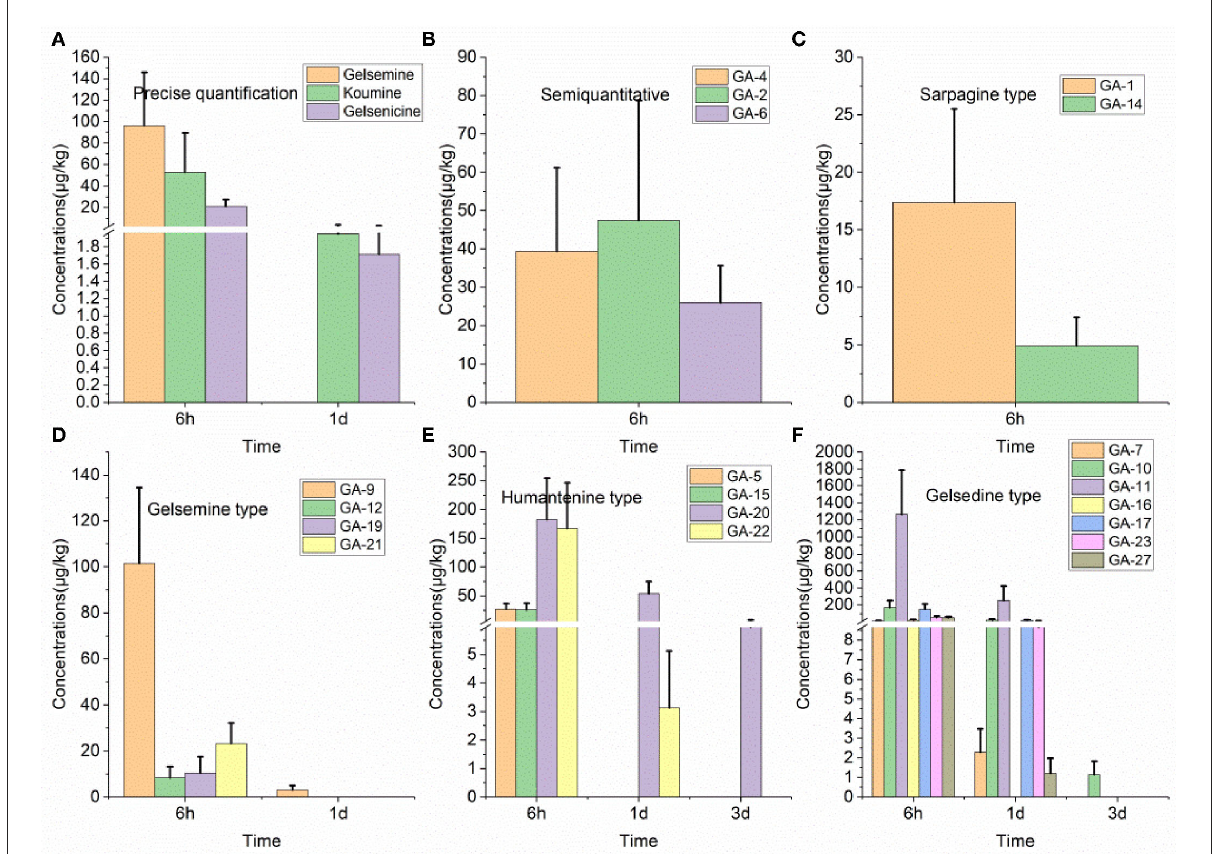
FIGURE3 (A–F) Depletion of Gelsemium alkaloids in pig small intestine after 45 d of consecutive administered G. elegans powder at a dose of 2% per kilogram